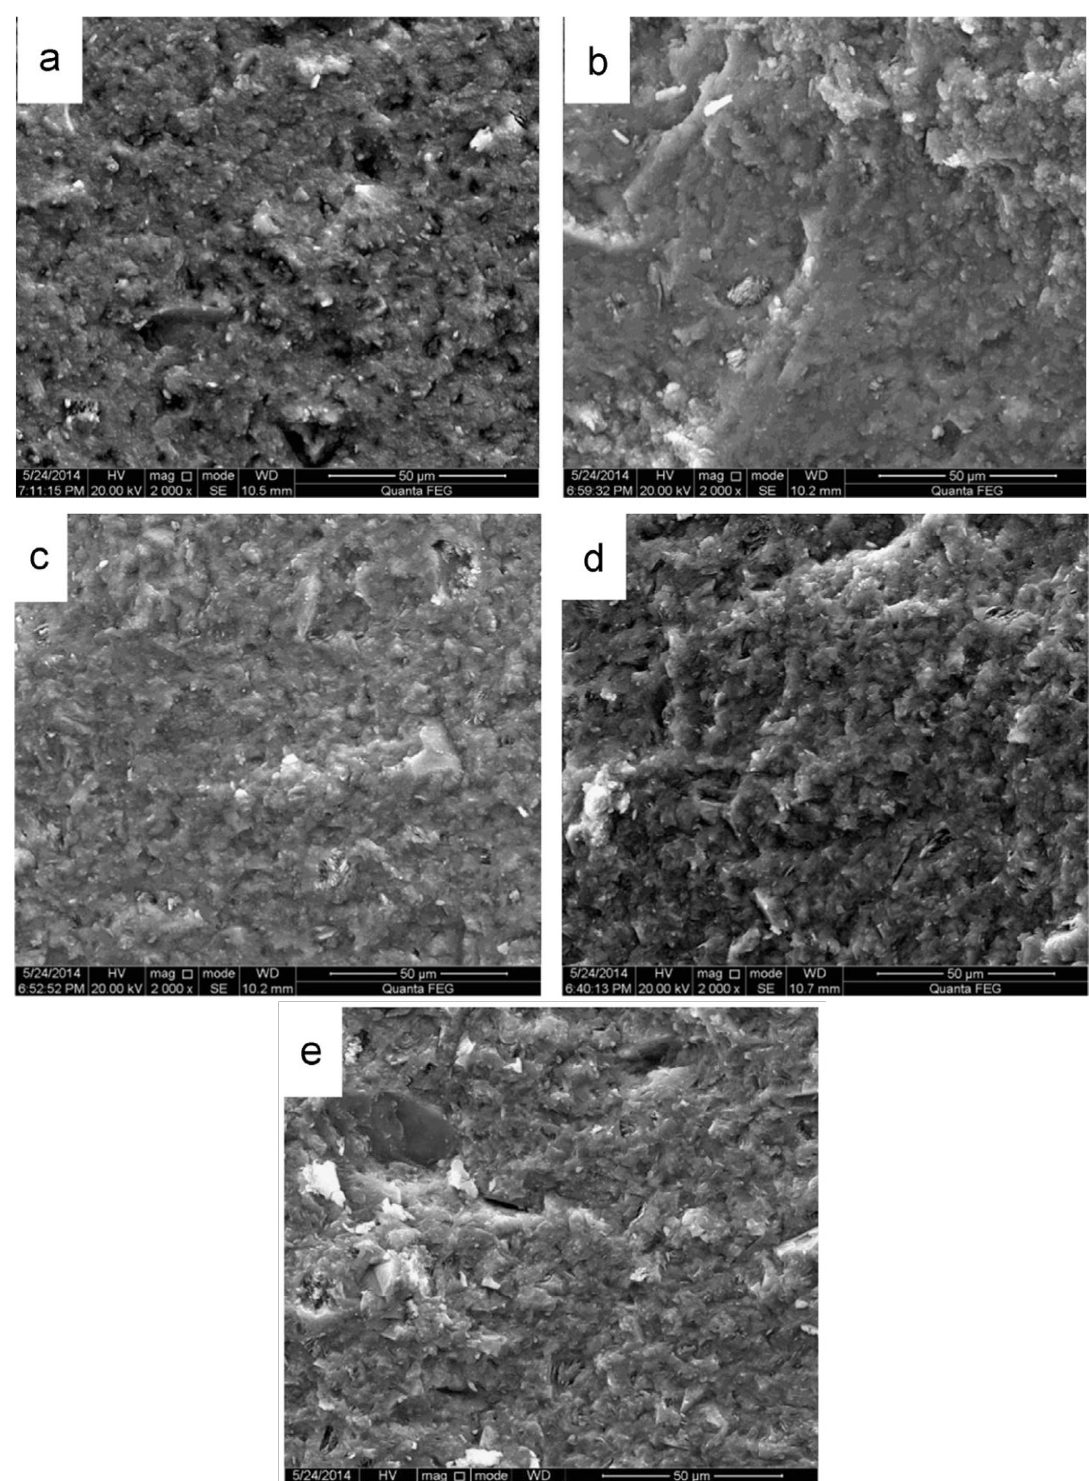
Figure 6: Typical fracture surface microstructure of rGO/GP composites with different rGO contents: (a) rGO/GP0; (b) rGO/GP0.5; (c) rGO/GP1; (d) rGO/GP3; (e) rGO/GP5